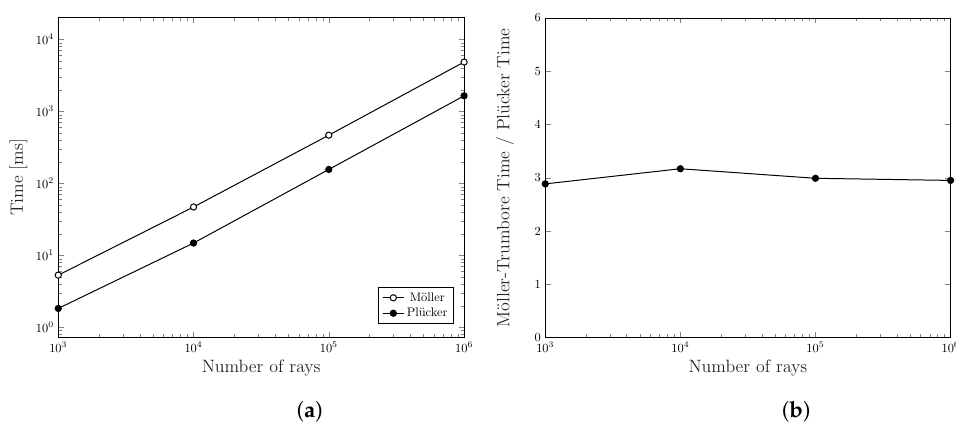
Figure 13. Computation time comparison for intersecting 10,000 triangles with an increasing number of rays using Möller-Trumbore and Plücker-based algorithms. ( a ) Computation time, ( b ) Ratio between the computation times of the two algorithms.